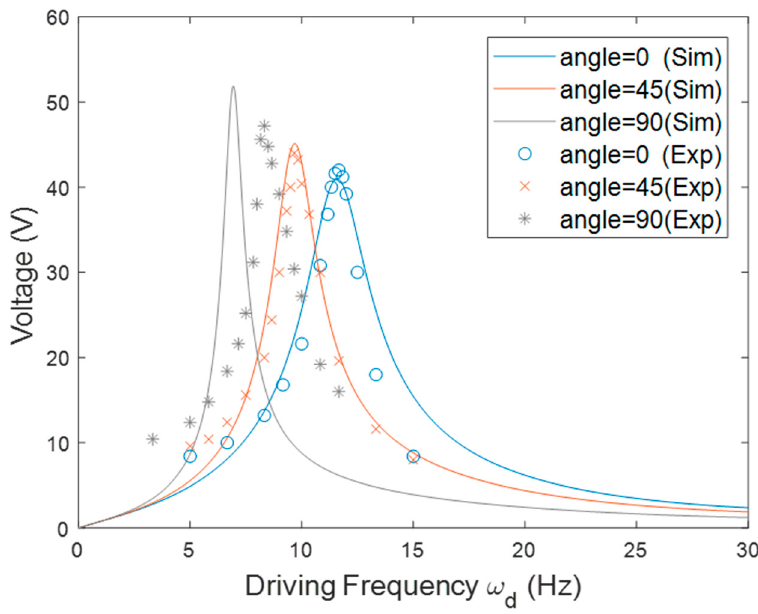
Figure 10. The simulation and experimental voltage responses of the PEH in the tilted orientation with different θ .